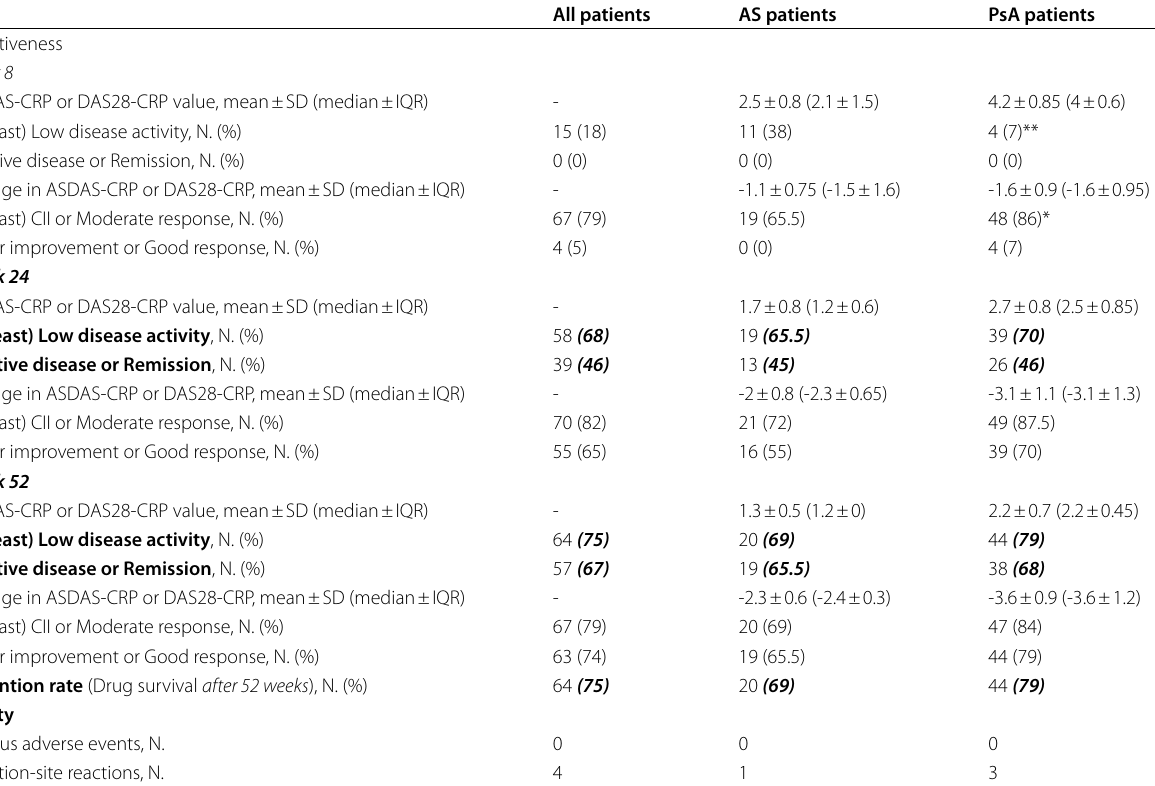
Table 2 Outcomes after 8, 24 and 52 weeks of treatment with Secukinumab